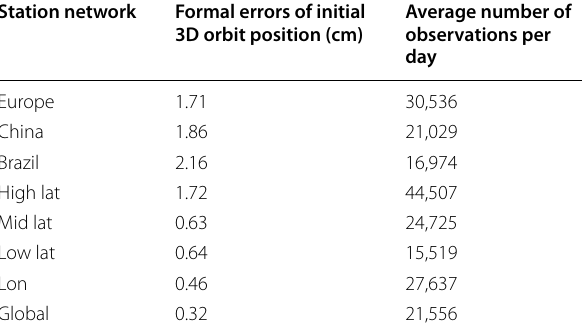
Table 3 Formal errors of initial 3D orbit position and average number of observations per day, all cases are without ISL